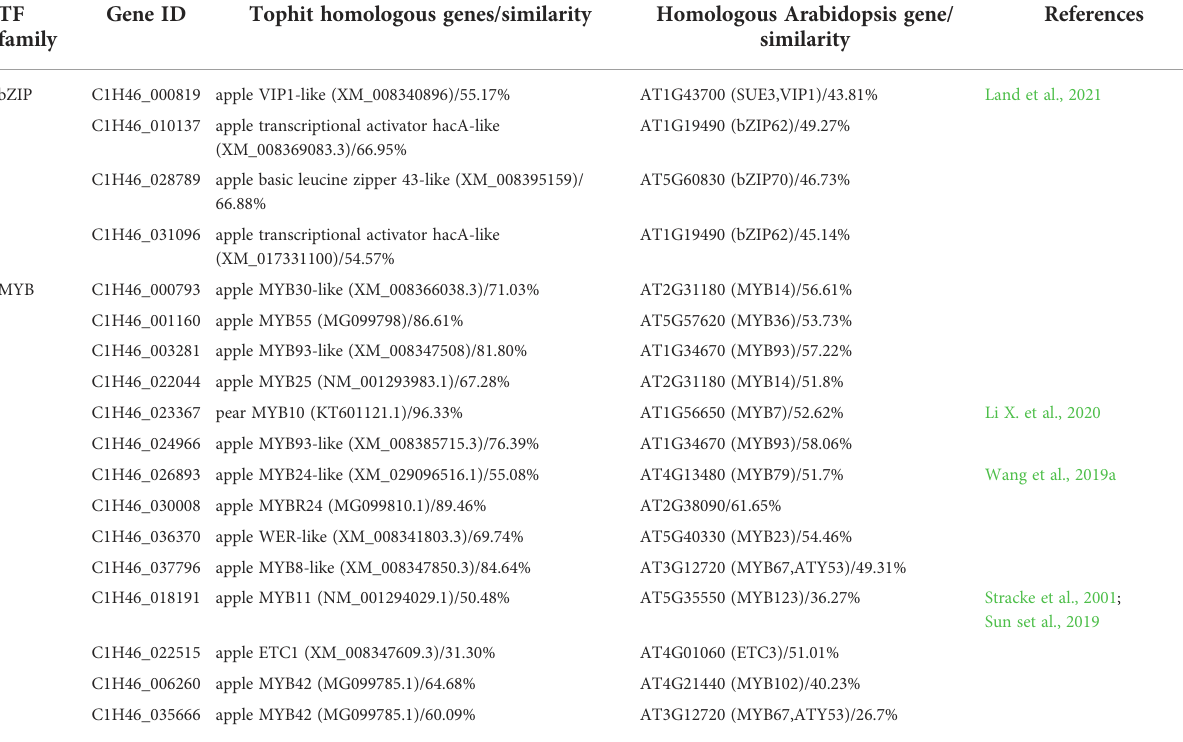
TABLE 1 The identi fi ed differentially expressed bZIP and MYB genes that showed opposite change patterns between PS5_vs_PS1 and PS9_vs_PS5 comparisons. TF Gene ID Tophit homologous family